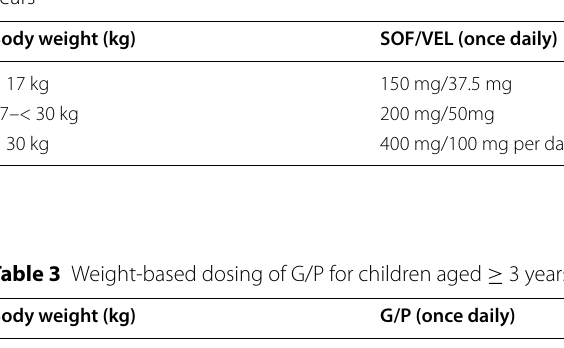
Table 2 Weight-based dosing of SOF/VEL for children aged